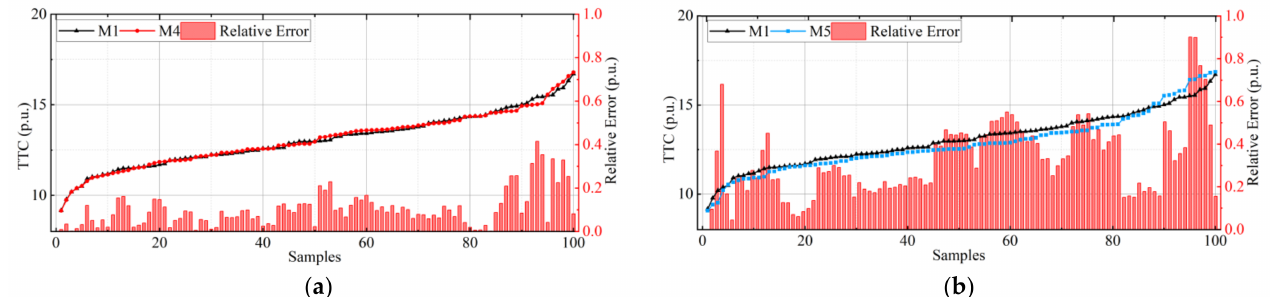
Figure 5 . The results of TTC calculation under four different methods: ( a ) M4 compared with M1; ( b ) M5 compared with M1.